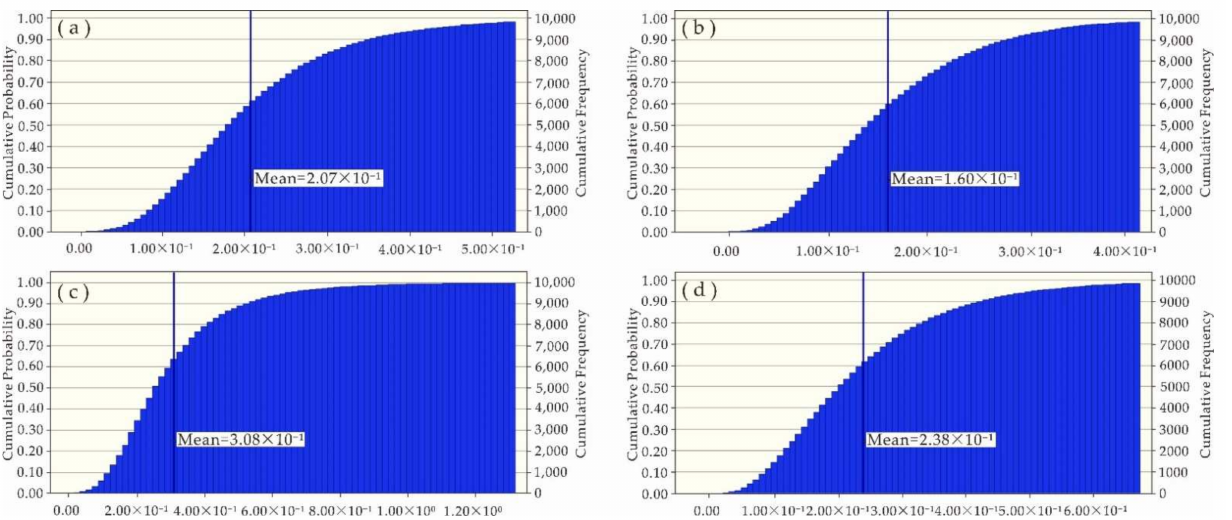
Figure 6. Simulated HQ (As) values of ( a ) adults on the left bank; ( b ) adults on the right bank; ( c ) kids on the left bank; and ( d ) kids on the right bank.